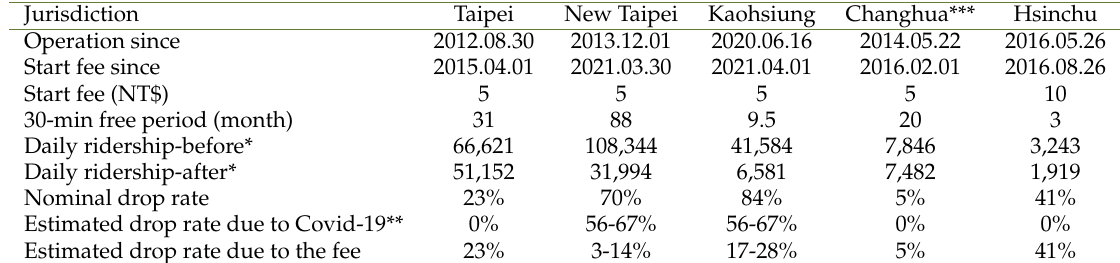
Table 2. Compilation of the bikesharing start fees in Taiwan